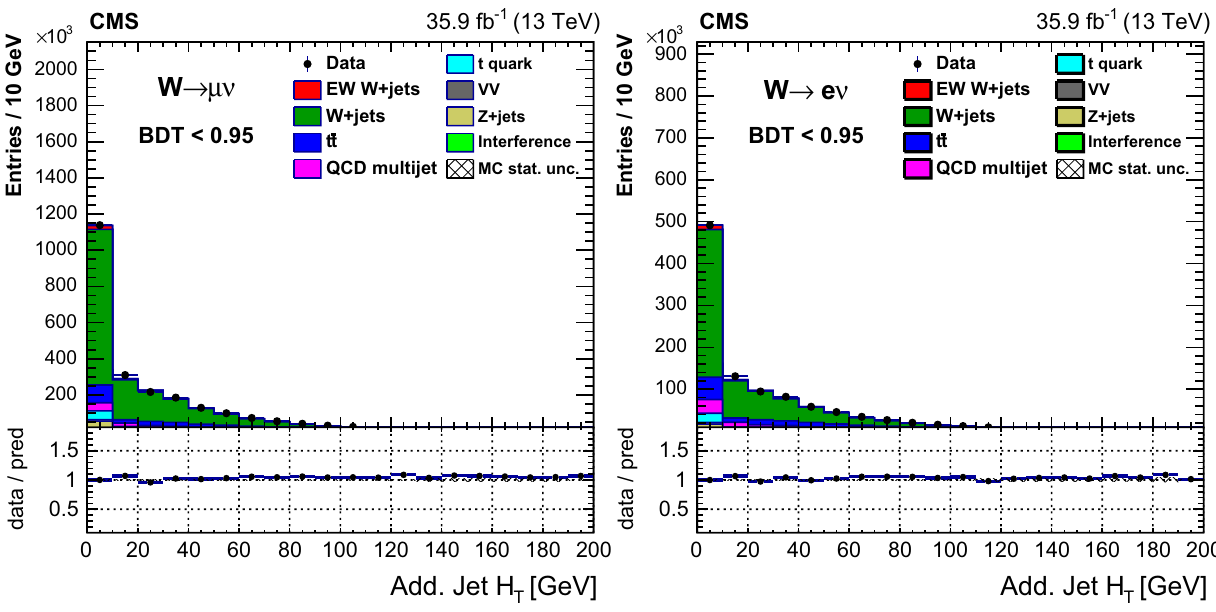
Fig. 23 Leading additional jet p T ( p T (j3)) for BDT < 0 . 95 in the muon (left) and electron (right) channels. In all plots the first bin contains events where no additional jet with p T > 15GeV is present